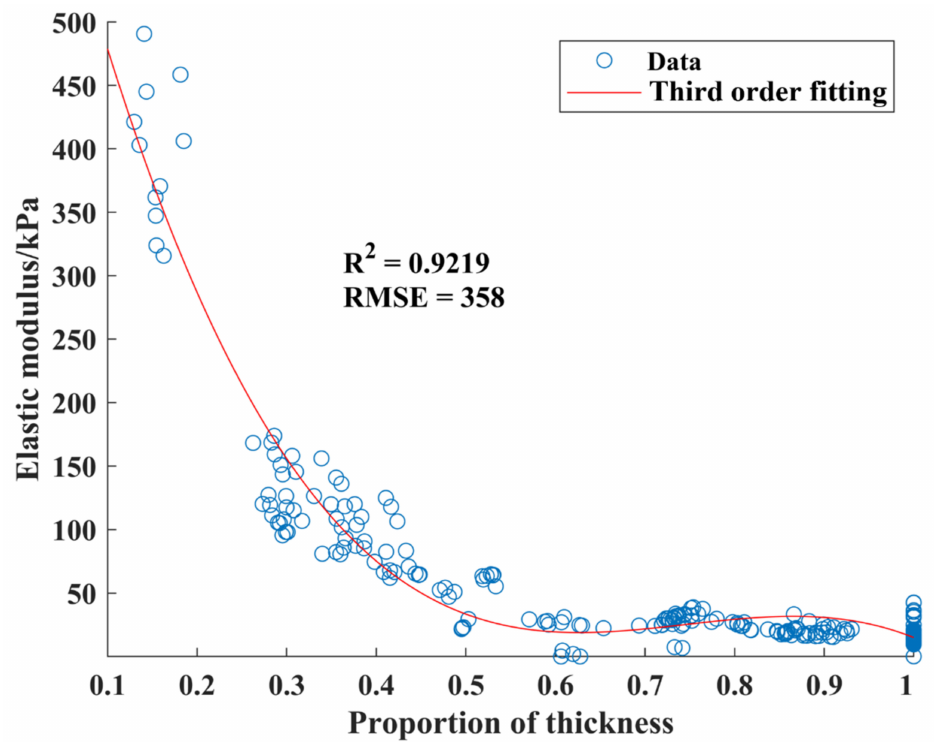
Figure 8. Correlation analysis between elasticity and thickness percentage. The data in this figure are from six sets of different corneal thickness